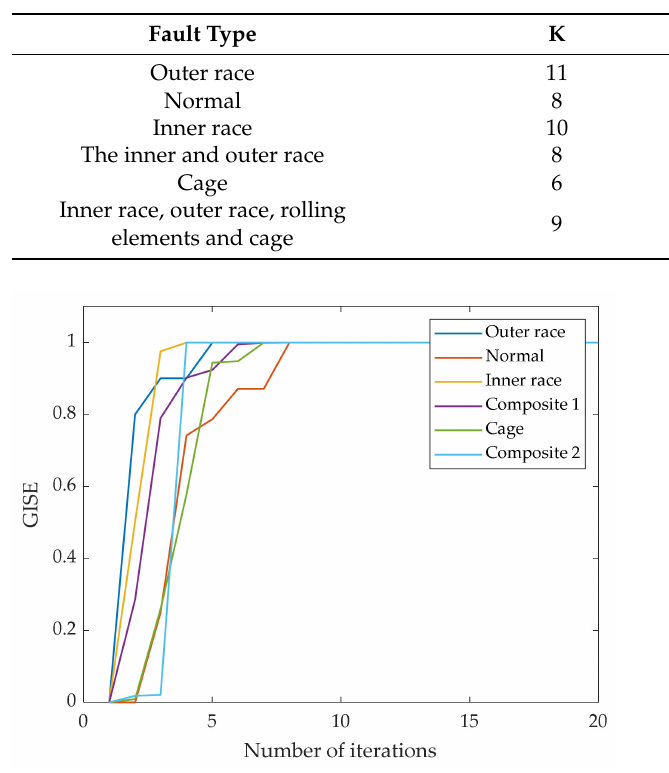
Figure 7. The convergence curve of the maximum GISE.